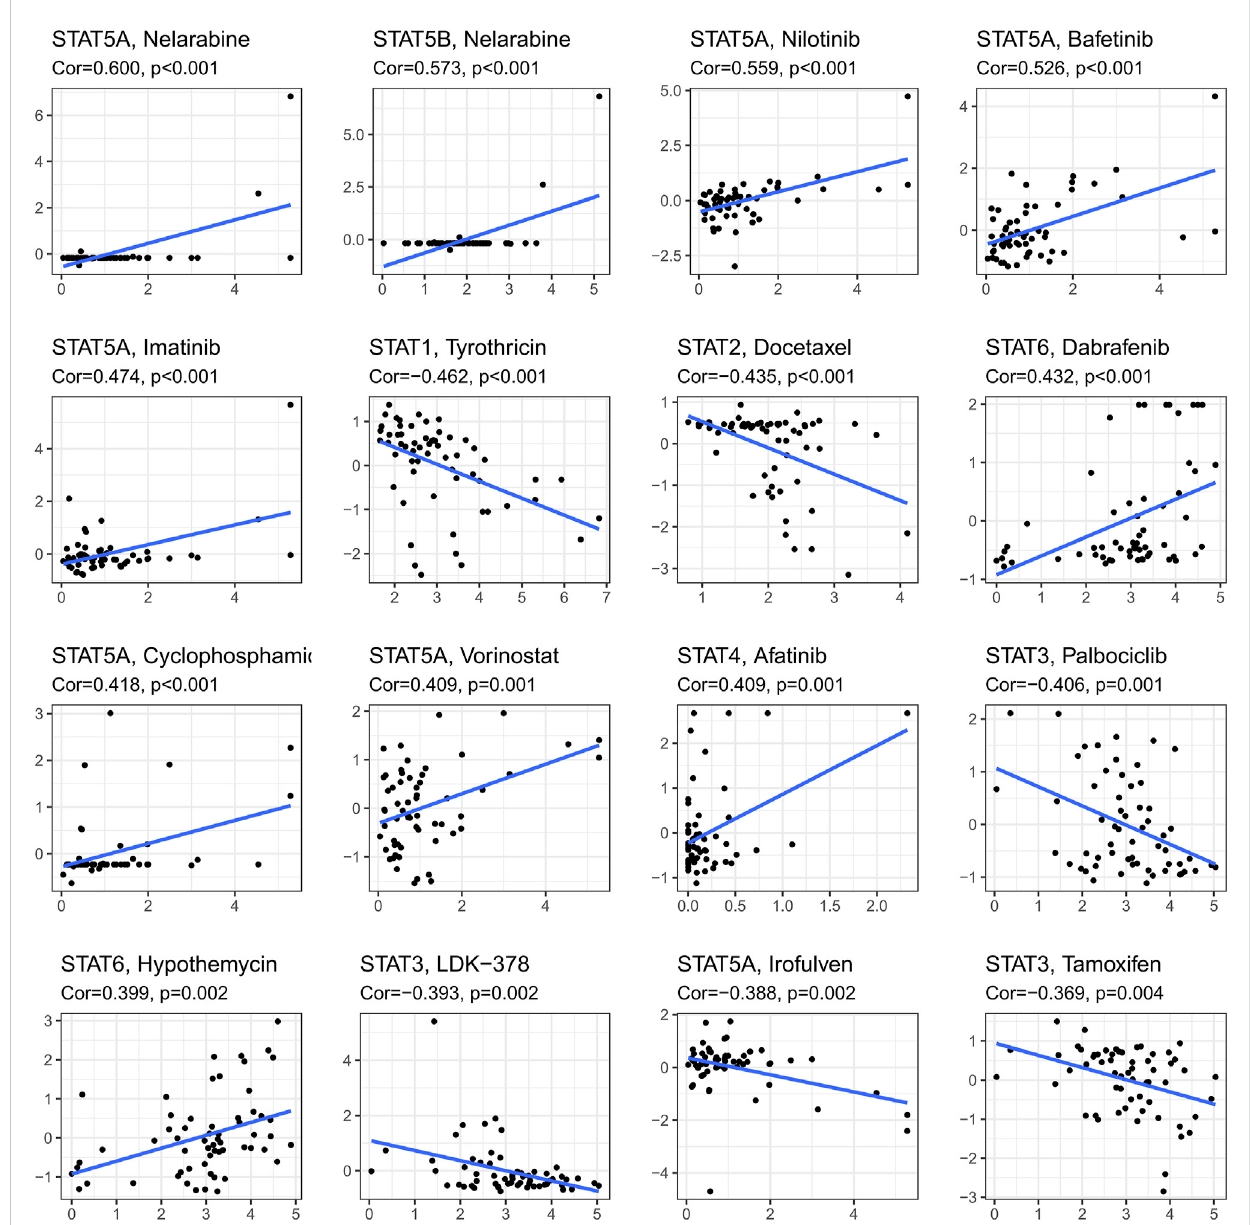
FIGURE 8 Drug response analysis. The results of correlations between drug sensitivity and STAT1, STAT2, STAT3, STAT4, STAT5A, STAT5B, and STAT6 across TCGA cancers, in which STAT5A expression was shown to have positive correlations with Nelarabine (cor = 0.600, p < 0.001), Nilotinib (cor = 0.599, p < 0.001), Bafetinib (cor = 0.526, p < 0.001), Imatinib (cor = 0.474, p < 0.001), Cyclophosphamide (cor = 0.418, p < 0.001), and Vorinostat (cor = 0.409, p = 0.001), while a negative correlation with Irofulven (cor = − 0.338, p = 0.002). Moreover, positive correlations were accessed between STAT5B and Nelarabine (cor = 0.573, p < 0.001), STAT6 and Dabrafenin (cor = 0.432, p < 0.001), and STAT4 and Afatinib (cor = 0.409, p = 0.001), while negative correlations were obtained between STAT1 and Tyrothricin (cor = − 0.462, p < 0.001), and STAT2 and Docetaxel (cor = − 0.435, p < 0.001). Furthermore, STAT3 was revealed to be negatively linked with Palbociclib (cor = − 0.406, p = 0.001), LDK-378 (cor = − 0.393, p = 0.002), and Tamoxifen (cor = − 0.369, p =